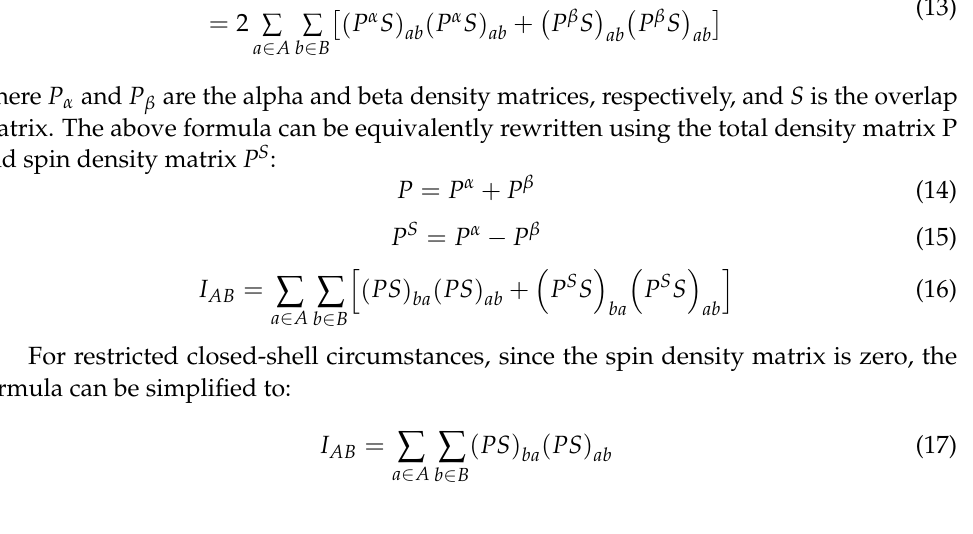
Table 2. The Mayer BOD values of N-NO 2 in